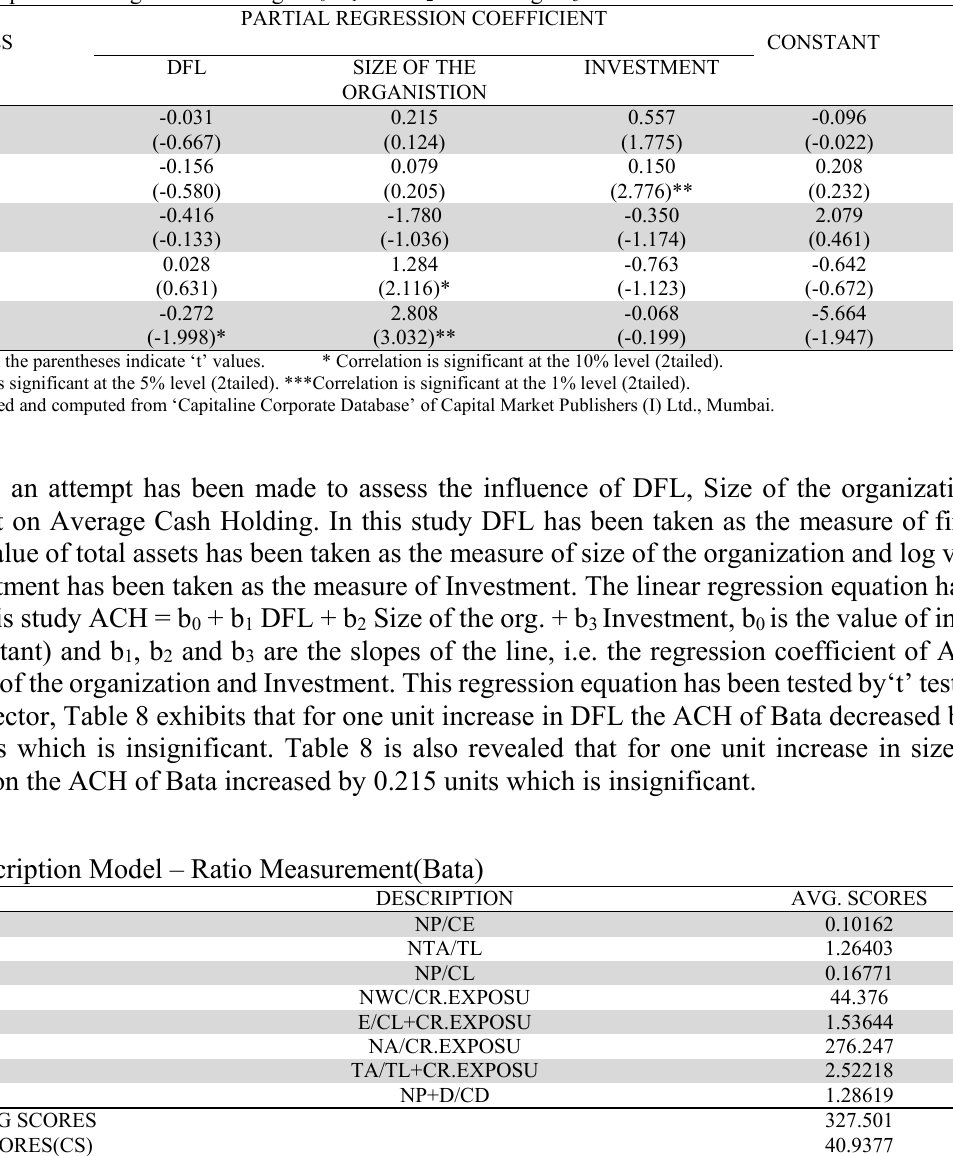
Analysis of Multiple Regression of Avg. Cash Holding on DFL, Size of Org. and Investment of the Selected Companies of Retail Sector.